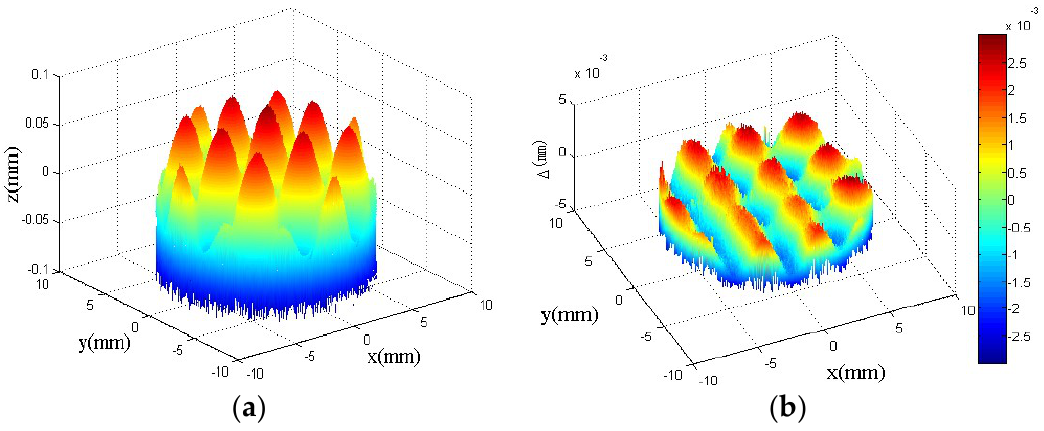
Figure 20. The measured results of PV values. ( a ) The model matching; ( b ) The deviation of matching.